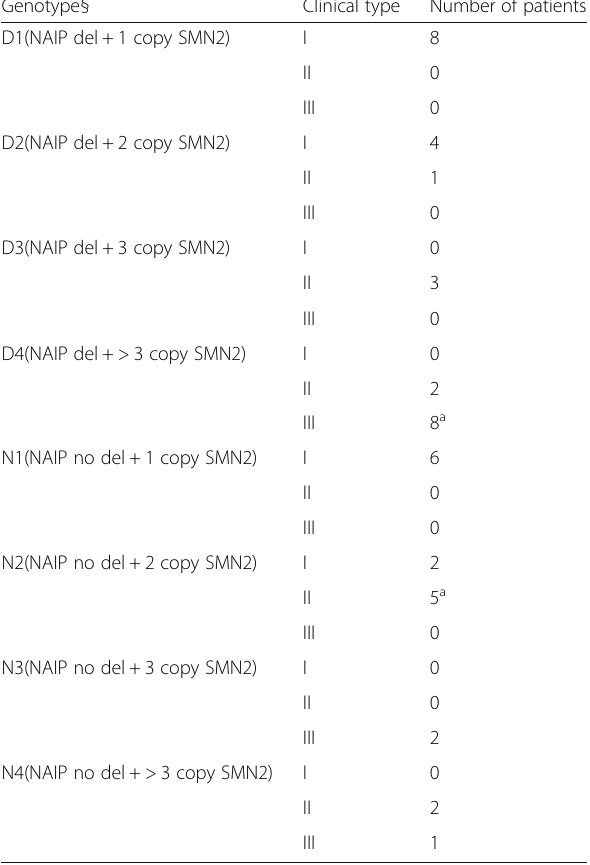
Table 1 Genotype combination and the related phenotype in the studied patients Genotype§ Clinical type Number of